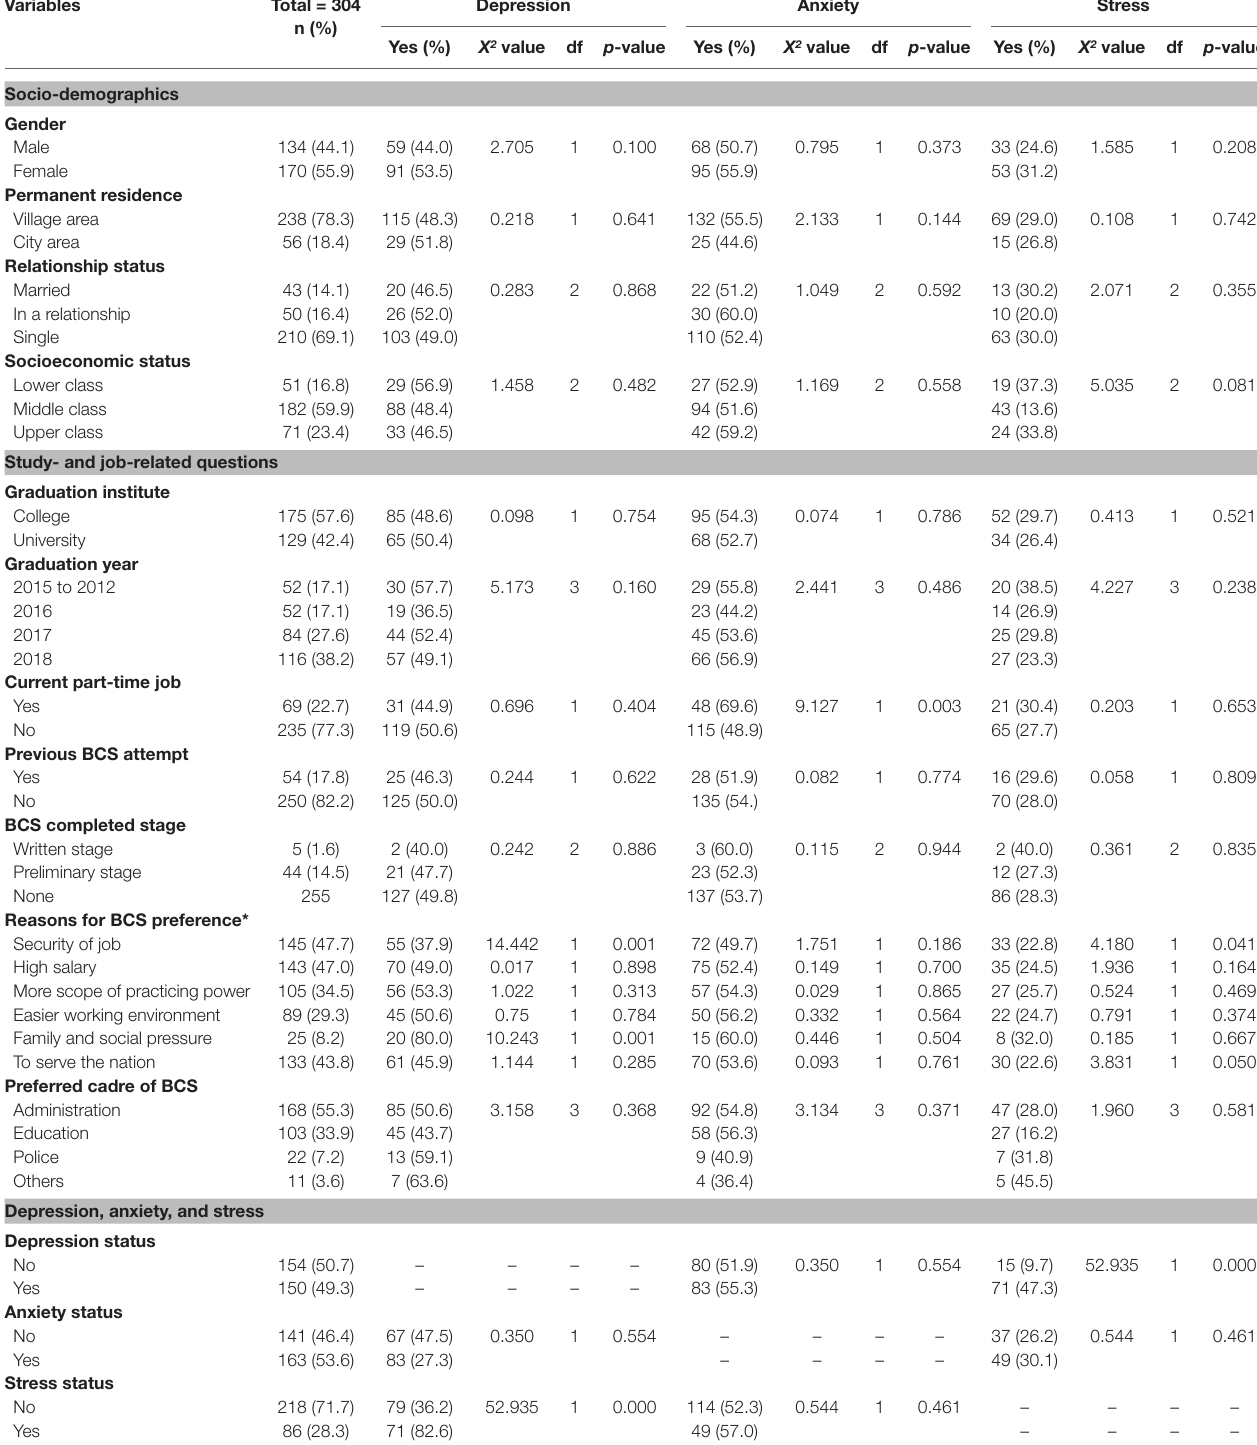
TABLE 1 | Distribution of variables among respondents by depression, anxiety, and stress.